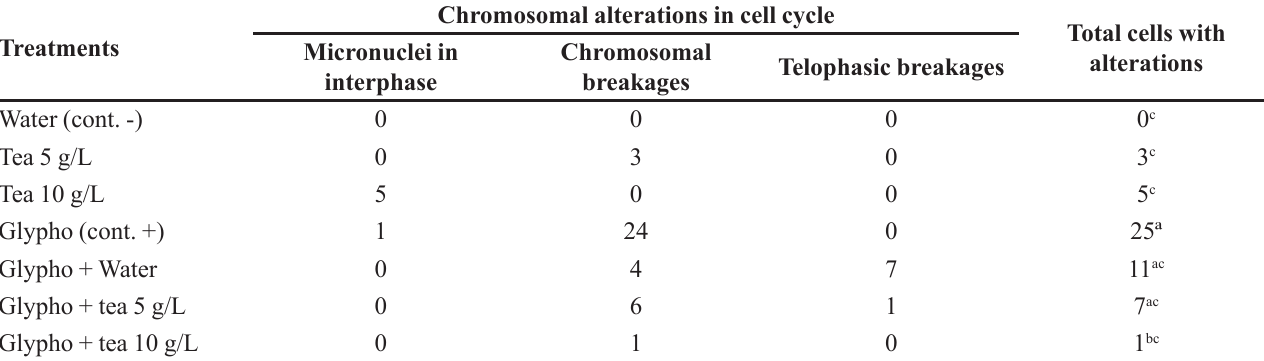
TABLE II – Chromosomal alterations found for the different treatments on Allium cepa test Treatments